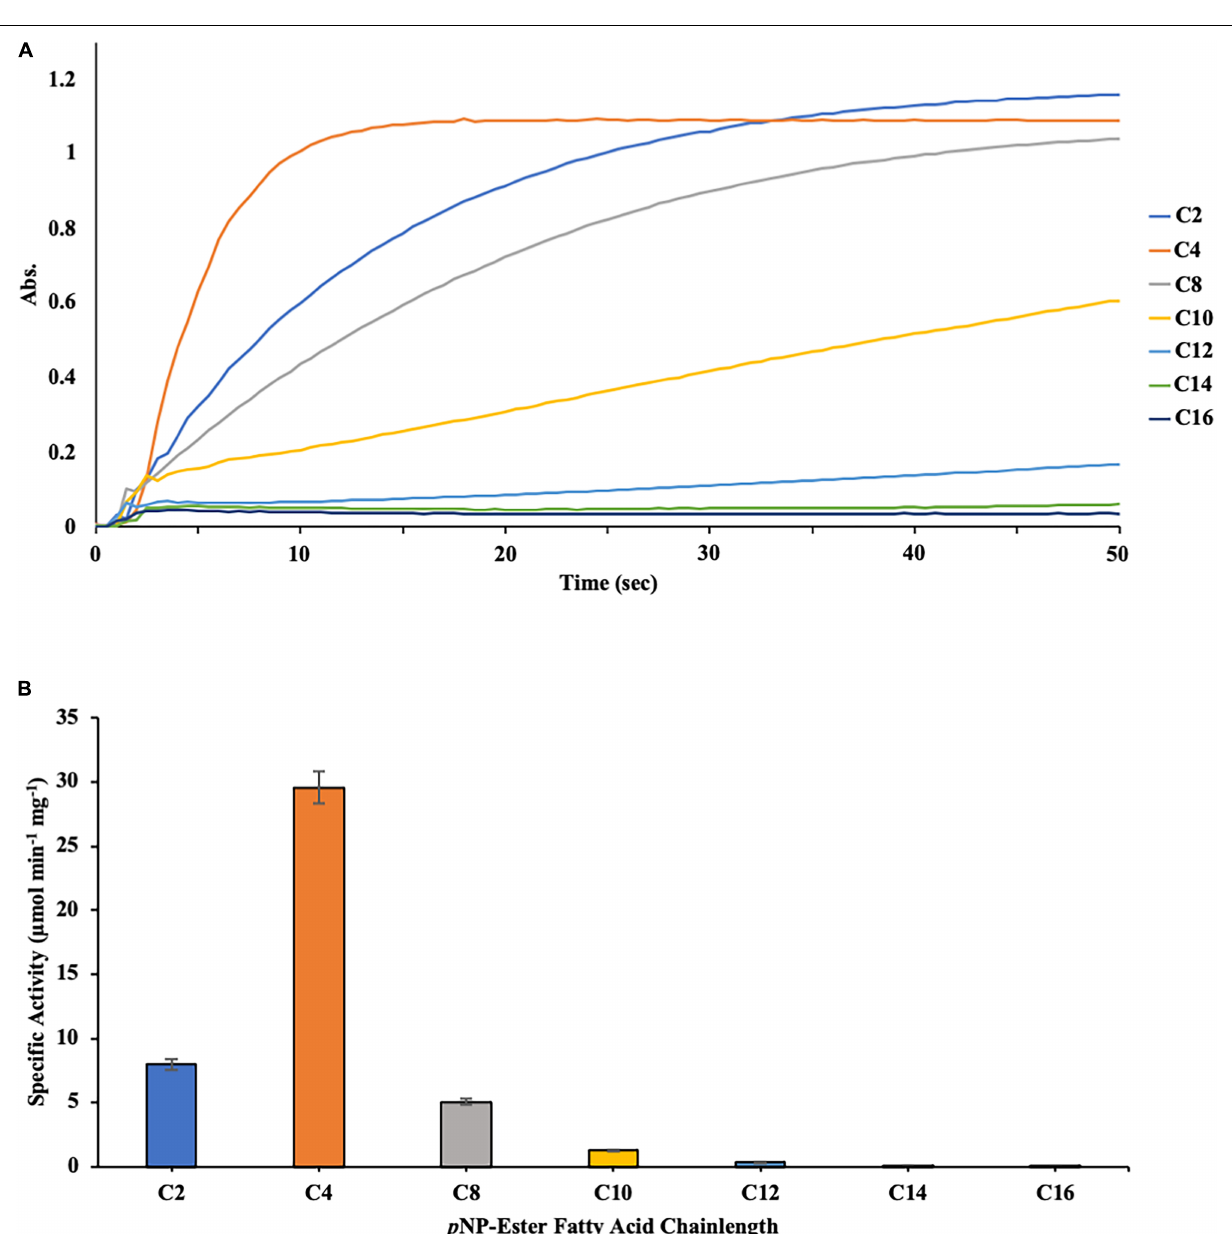
Frontiers in Microbiology |